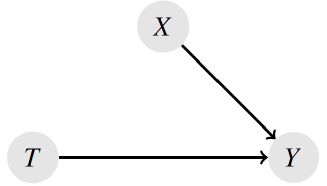
Figure 2. Directed acyclic graph showing no